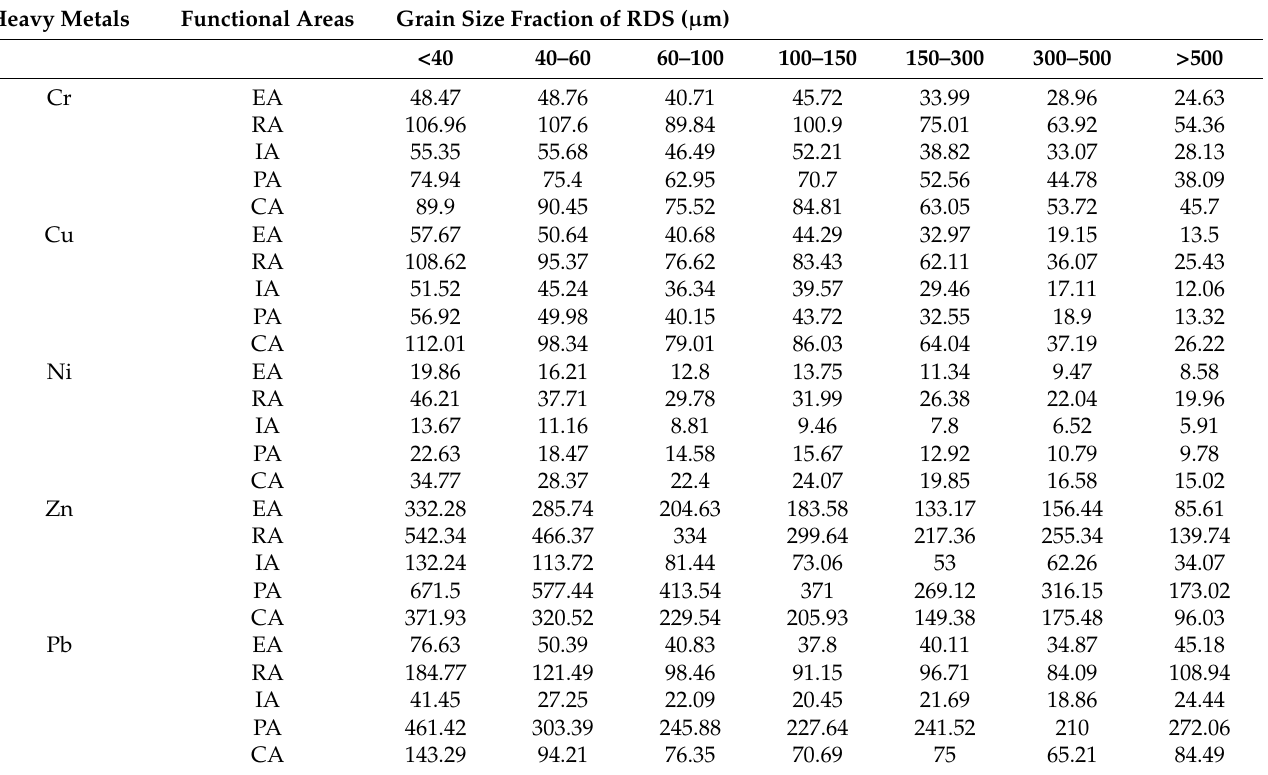
Table 3. Concentrations of heavy metals (mg/kg) in different grain size fractions for different functional